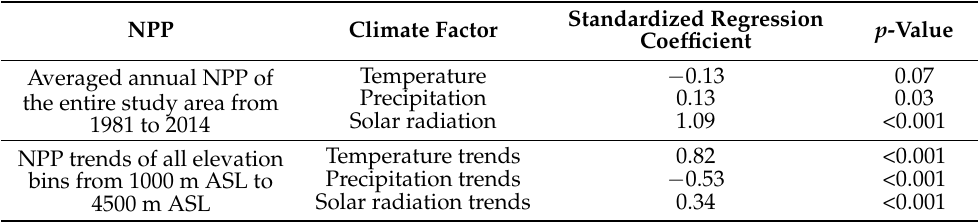
Table 1. Linear regression results between cropland ecosystem NPP and climate factors.